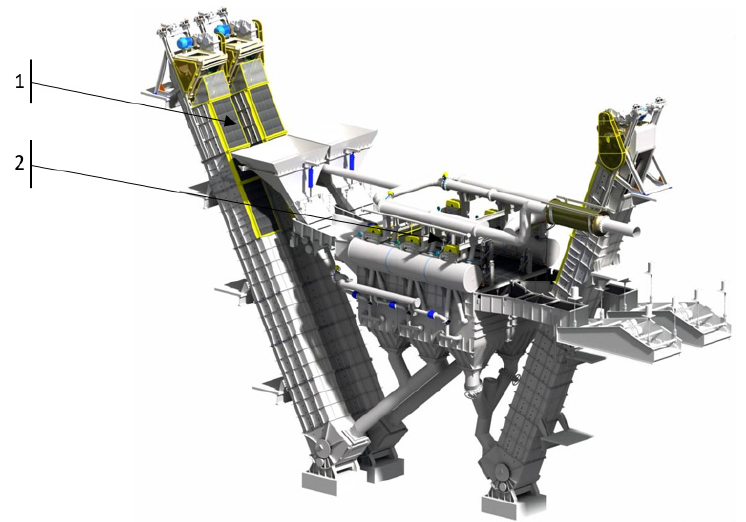
Figure 1. Pulsating jig: 1—bucket conveyor, 2—jig.